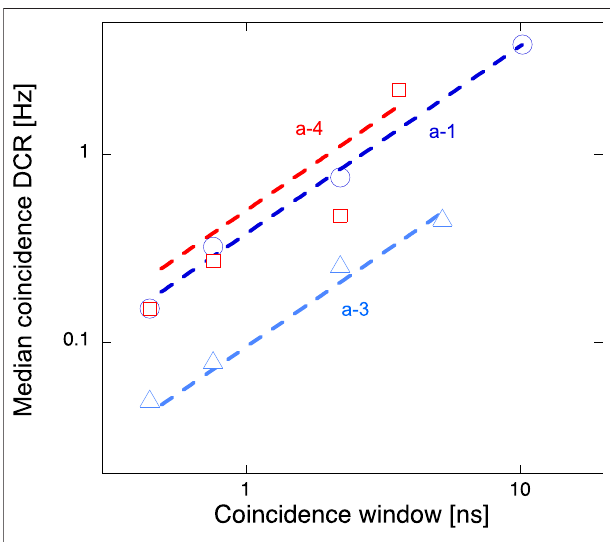
FIGURE 13 | Estimated coincidence DCR cumulative distribution for a dual-layer a -1 array obtained from two single-layer distributions. A comparison with the coincidence DCR cumulative distribution from a dual- layer structure is proposed. The coincidence window duration is 2 ns.